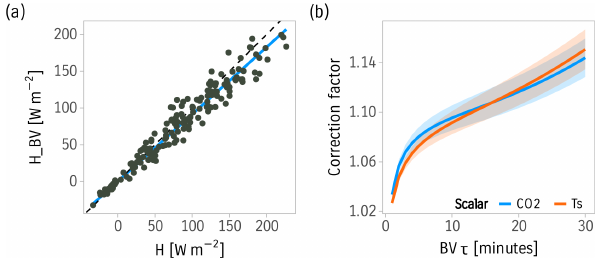
Figure 10. Empirical buffer volume correction. (a) Effect of buffer volume attenuation on sensible heat flux with a time constant τ = 11min. The blue solid line is the linear fit between the two. (b) Em- pirical correction factor for the effect of buffer volumes calculated as the reciprocal of the slope of attenuated flux for CO 2 and sen- sible heat flux. Bands are the estimated slope ± 1 standard error of the